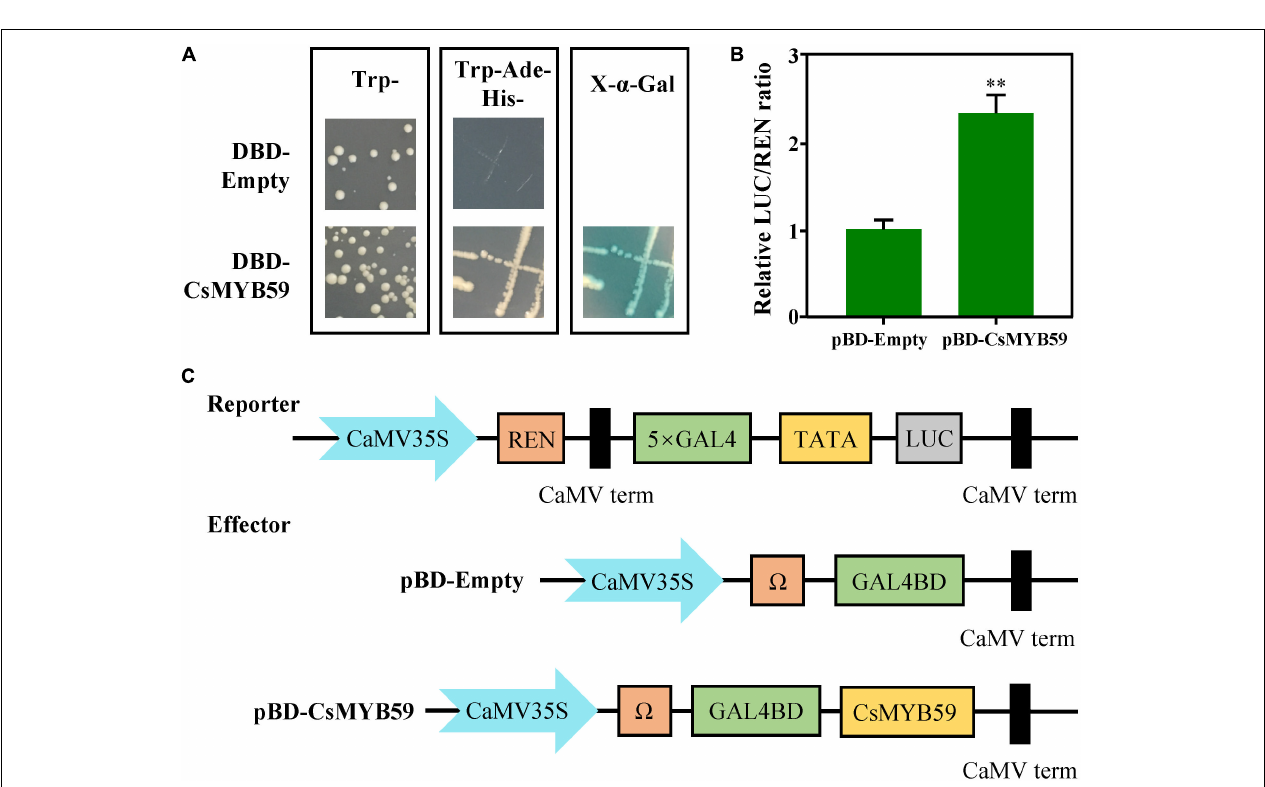
FIGURE 4 | Transcriptional activity analysis of CsMYB59. (A) Transcriptional activation of CsMYB59 in Saccharomyces cerevisiae . CsMYB59 was subcloned into a pGBKT7 vector and then transformed into yeast cells. The transformed yeast cells were grown on selective SD mediums (SD/-Trp/-His/-Ade), and further selected via X-Gal assays. (B,C) The relative REN/LUC ratio of CsMYB59 and pBD-empty was calculated to evaluate the transcriptional activity of CsMYB59. Transcriptional activation of CsMYB59 in tobacco. The transcriptional activation of CsMYB59 was verified via dual-luciferase reporter assays using Nicotiana benthamiana leaves. ∗∗ represents significant difference at P < 0.01. SD, synthetic defined; -Trp/-His/-Ade, media lacking tryptophan, histidine, and adenine; LUC, luciferase; REN, Renilla luciferase; X-Gal, X- α